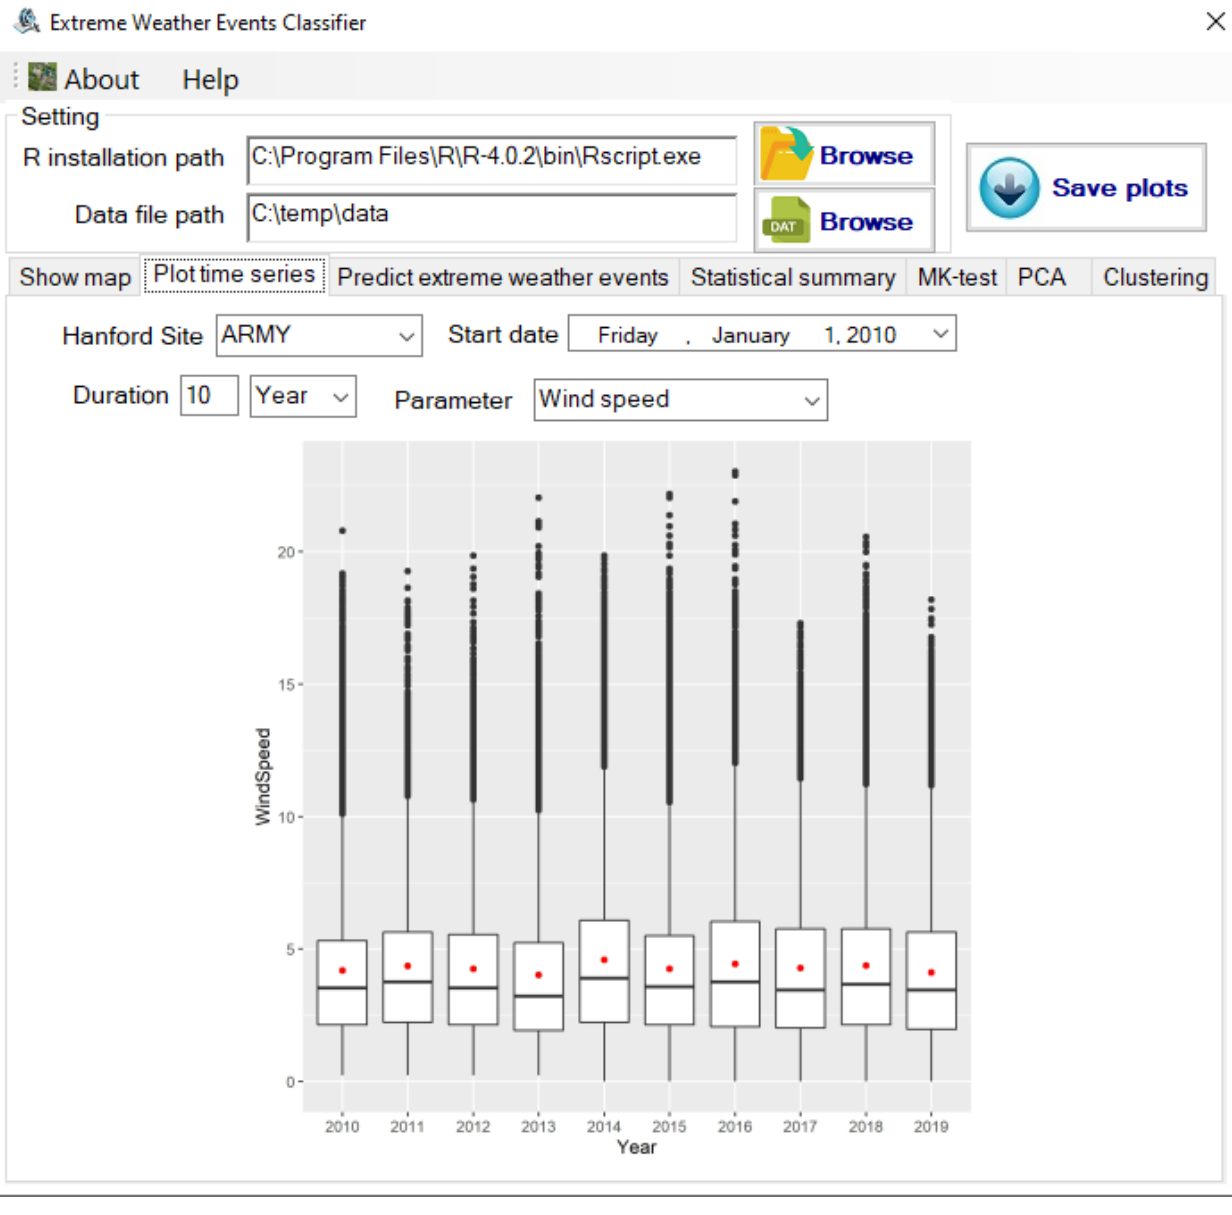
Figure 6. The plotted time series of wind speed from 2010 to 2019 for station ARMY.